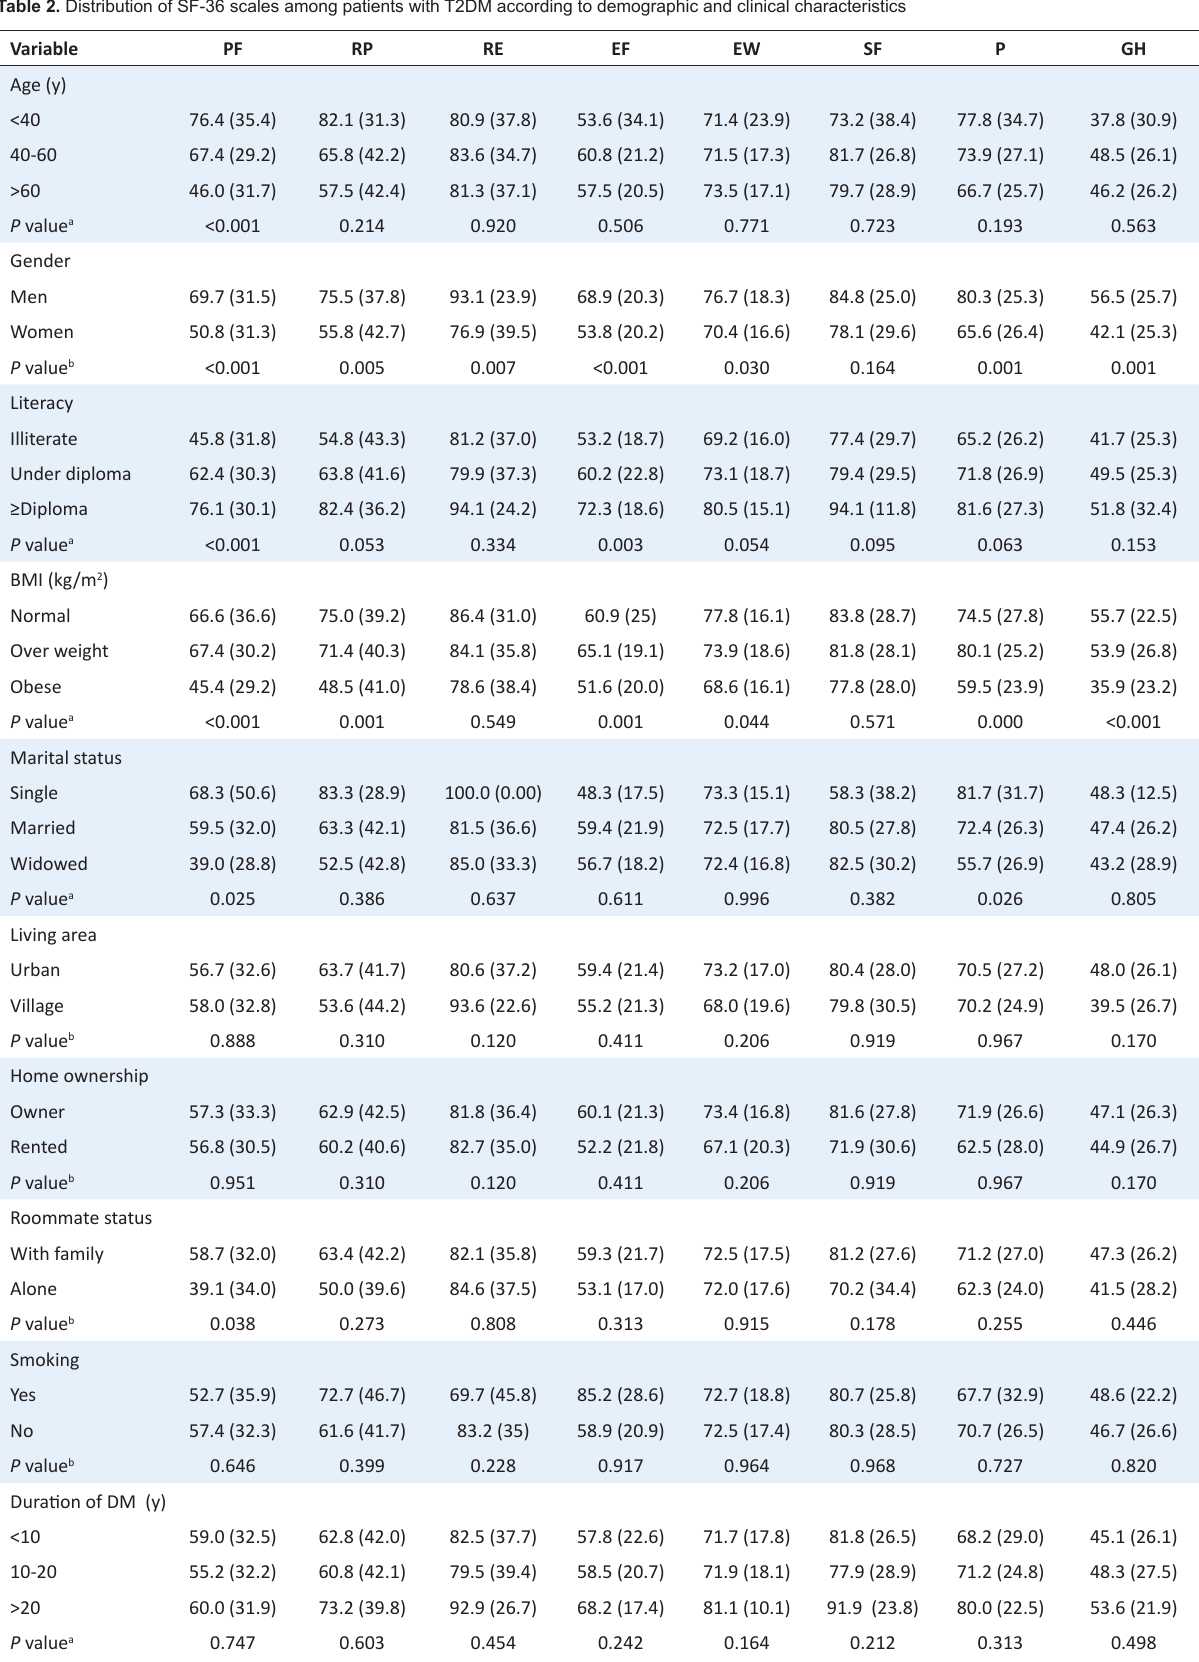
Table 2. Distribution of SF-36 scales among patients with T2DM according to demographic and clinical characteristics